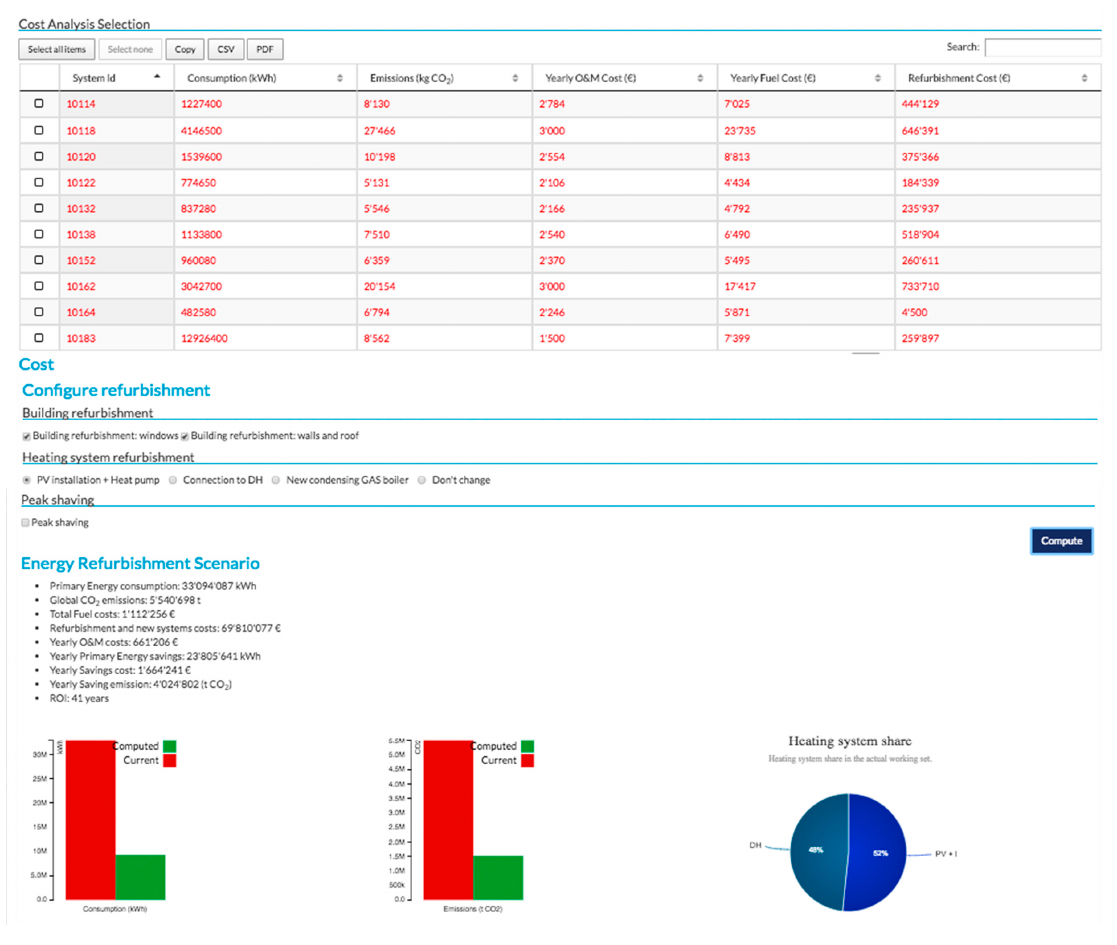
Figure 4. The EAA tool integrated into Dashboard.